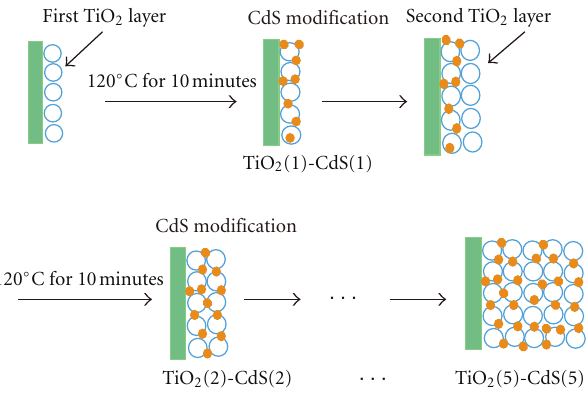
Figure 1: The preparation process of multilayer CdS-sensitized TiO 2